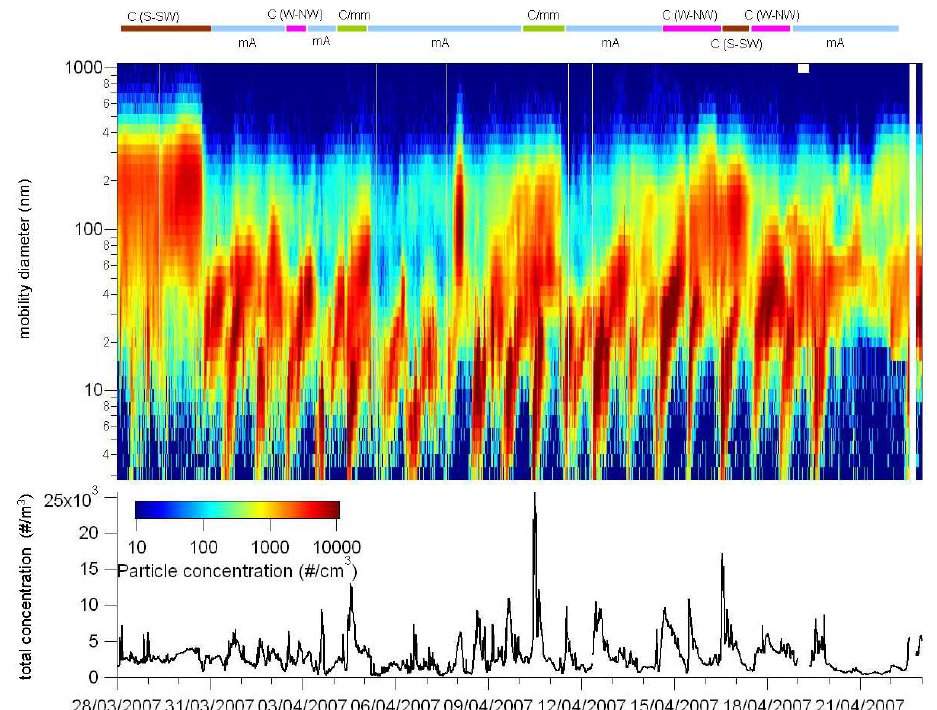
Fig. 4. Aerosol number size distribution measured by DMPS. Colours coded labels for the BTs distinct periods shown in Fig. 2 are also reported on the top.